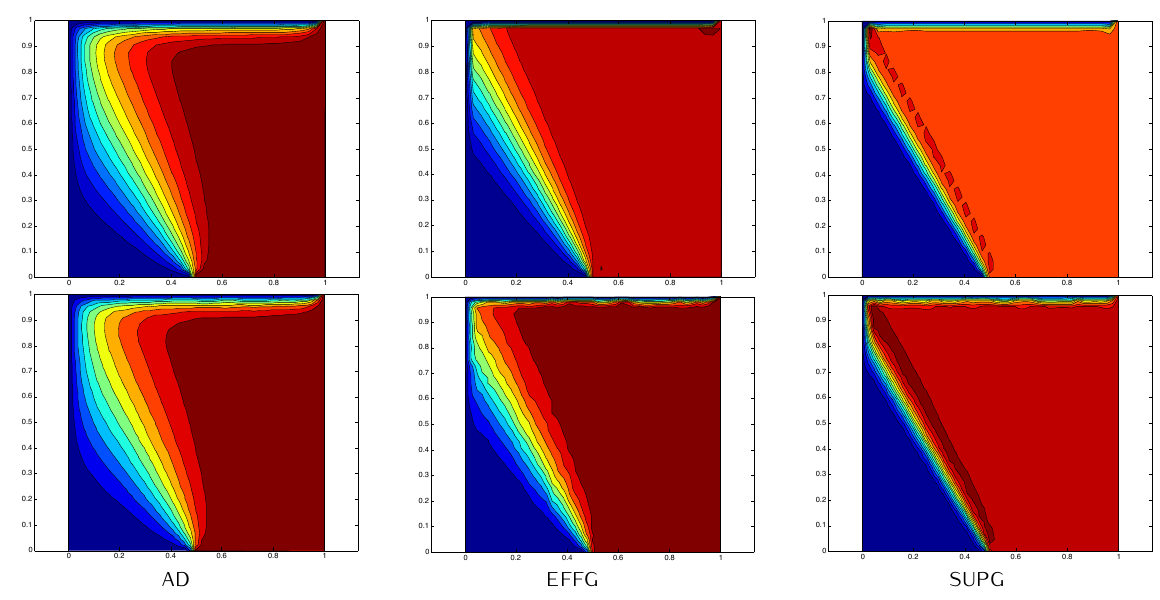
Figure 4. Solution of the skew advection test problem (30) with ε = 0 . 00001 by AD (left) vs. EFFG (middle) and SUPG (right) on 33 × 33 grids. Top row: uniform grid. Bottom row: randomly perturbed grid.